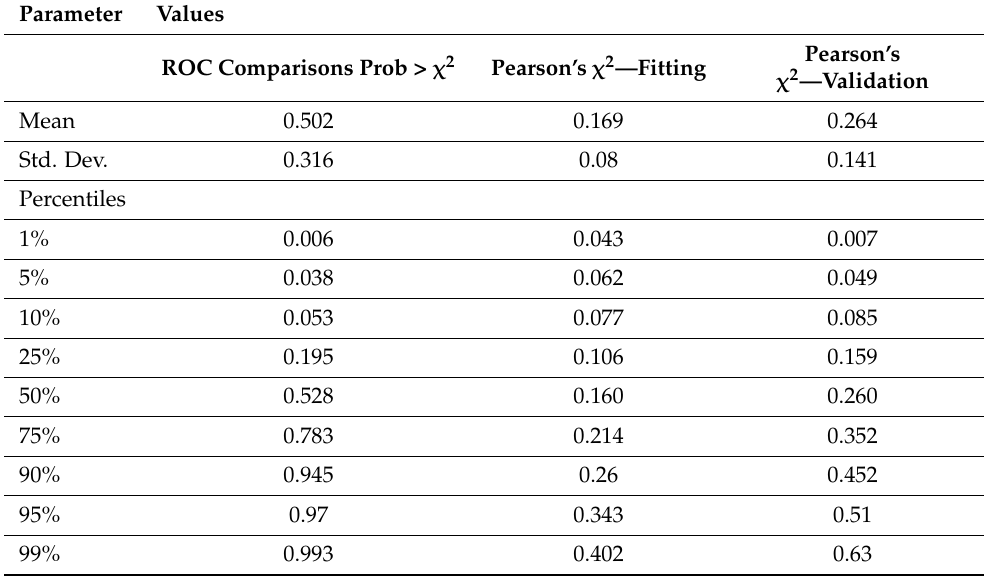
Table 2. Distribution of performance measures—household pooled model